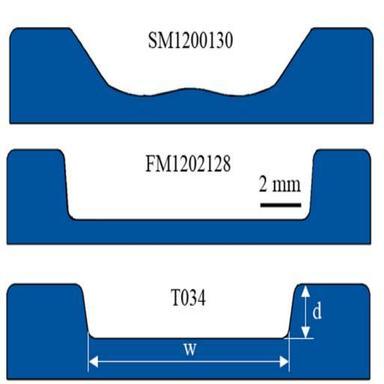
Used die geometries with die geometry parameters. Fig. 6. Simulation model.